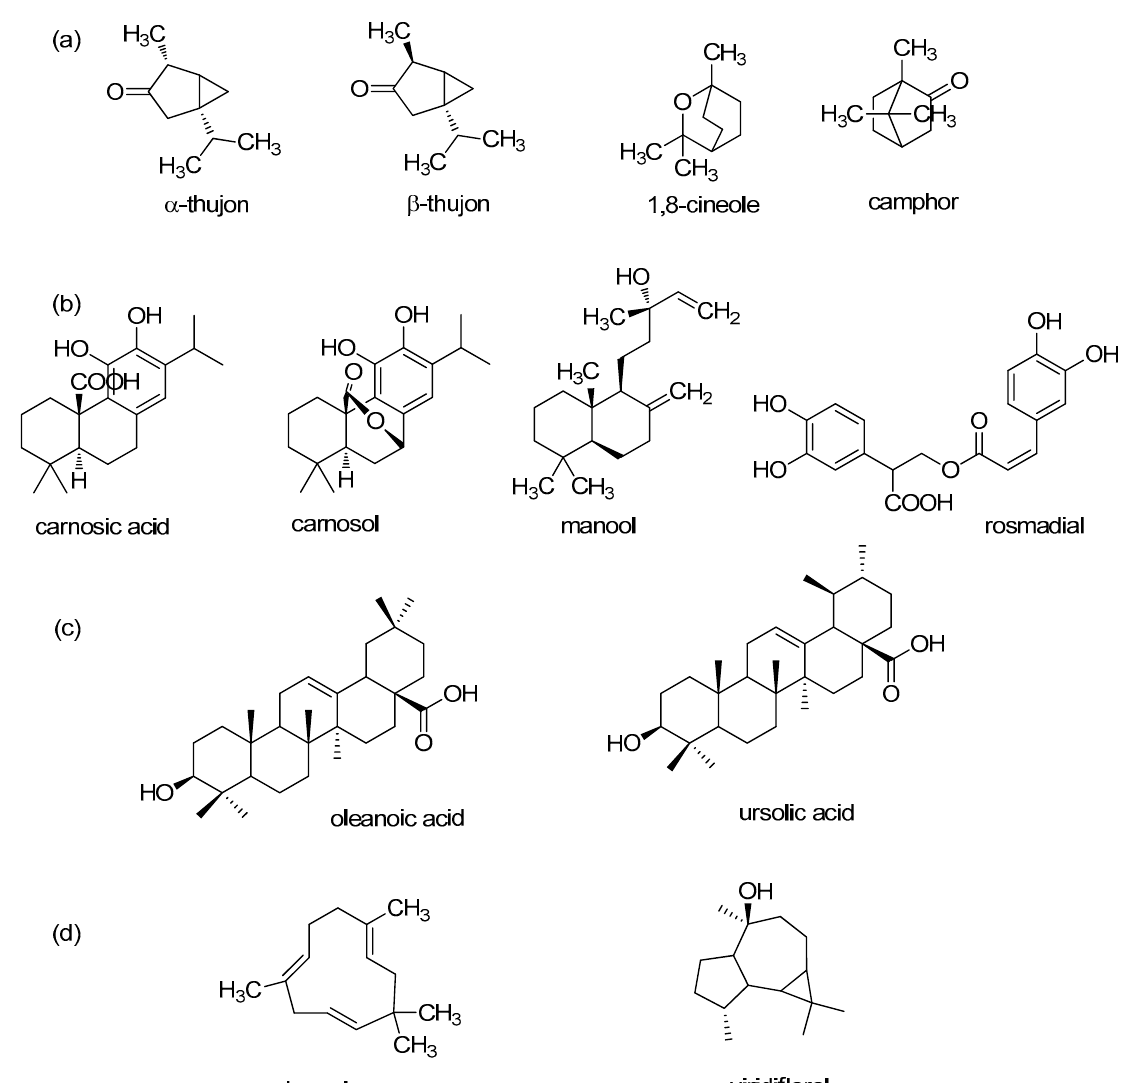
Figure 2. Major terpenes in sage extract; ( a ) monoterpenes; ( b ) diterpenes; ( c ) triterpenes; and ( d ) sesquiterpenes.